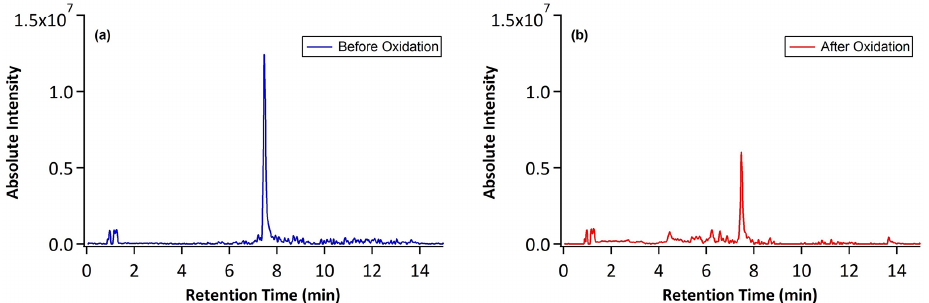
Figure 1. The total ion chromatograms (TIC) characterized by HPLC/ESI-QToF-MS before and after heterogeneous OH oxidation of α pOS- 249.